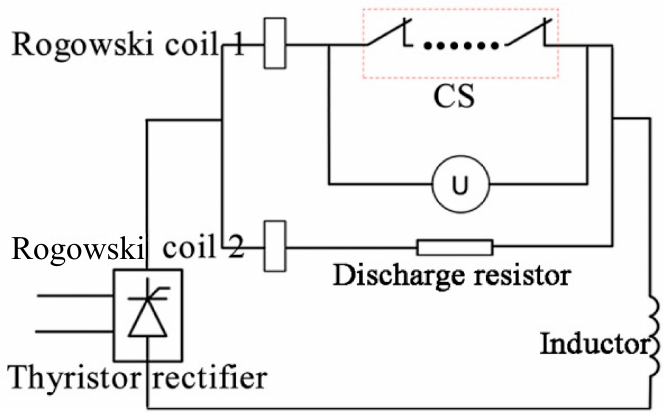
Figure 4. The circuit of the commutation